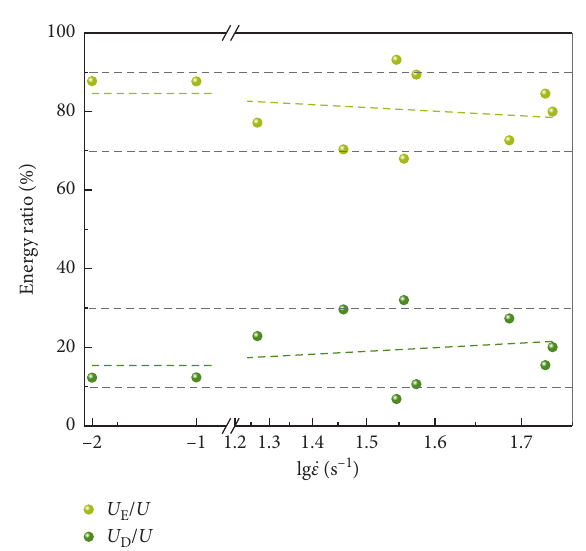
Figure 11: Relationship between the energy ratio and strain